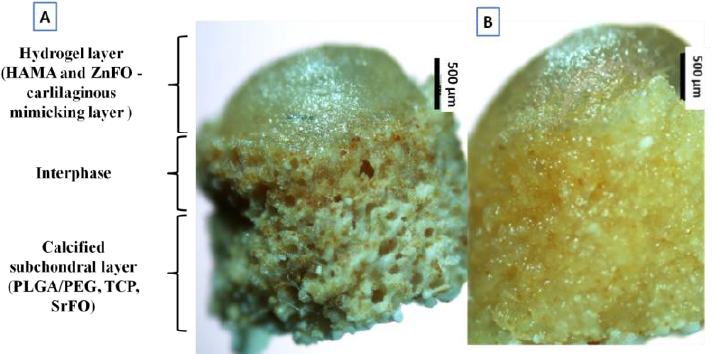
Figure 2. ( A ) Optical microscopy observation of the stratified microstructure of dry scaffolds (150× magnification); the porous support mimics the calcified subchondral layer, HAMA hydrogel recreates the cartilage region, and the intermediate region exhibits a combination of characteristics of regions with different composition and microstructure. ( B ) Optical microscopy of the surface gradient scaffolds after immersion in aqueous media (150× magnification).